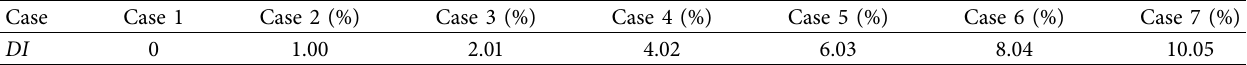
Table 3: Damage cases.